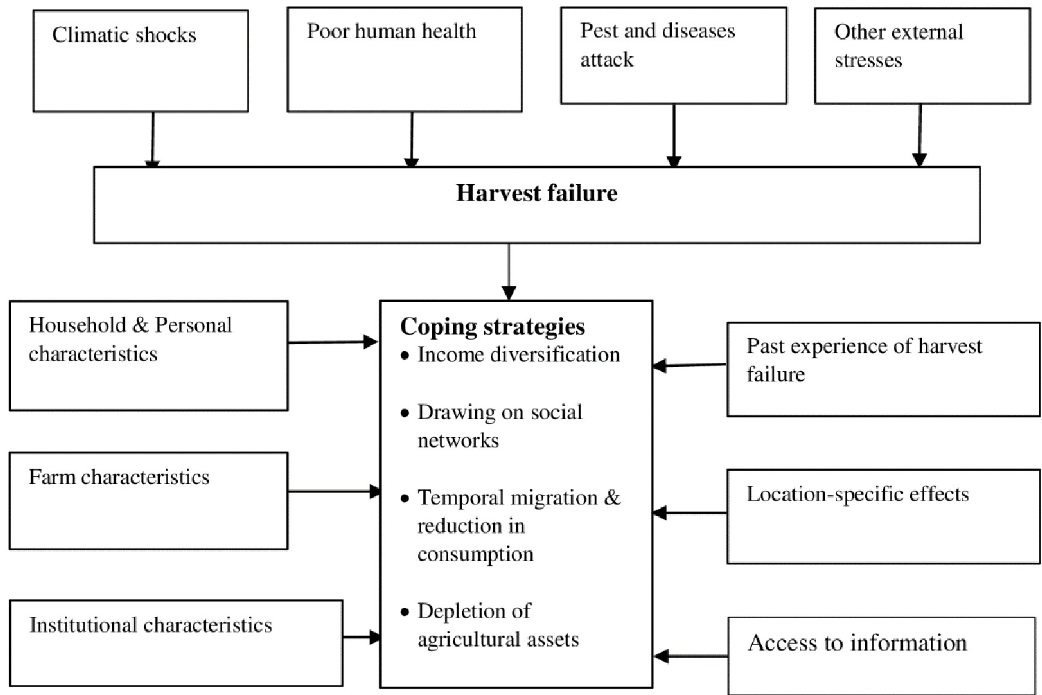
Fig 1. Conceptual framework. Source: Authors’